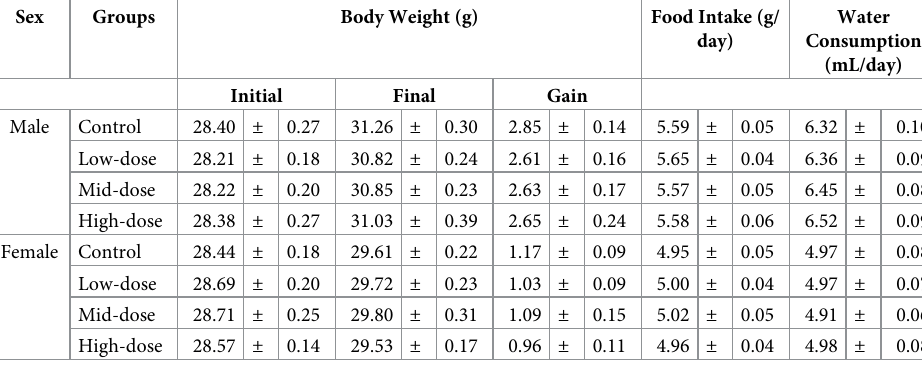
Table 3. Body weights, food intakes, and water consumption in SAMP8 mice fed with different doses of erinacine A-enriched H . erinaceus mycelia for 13